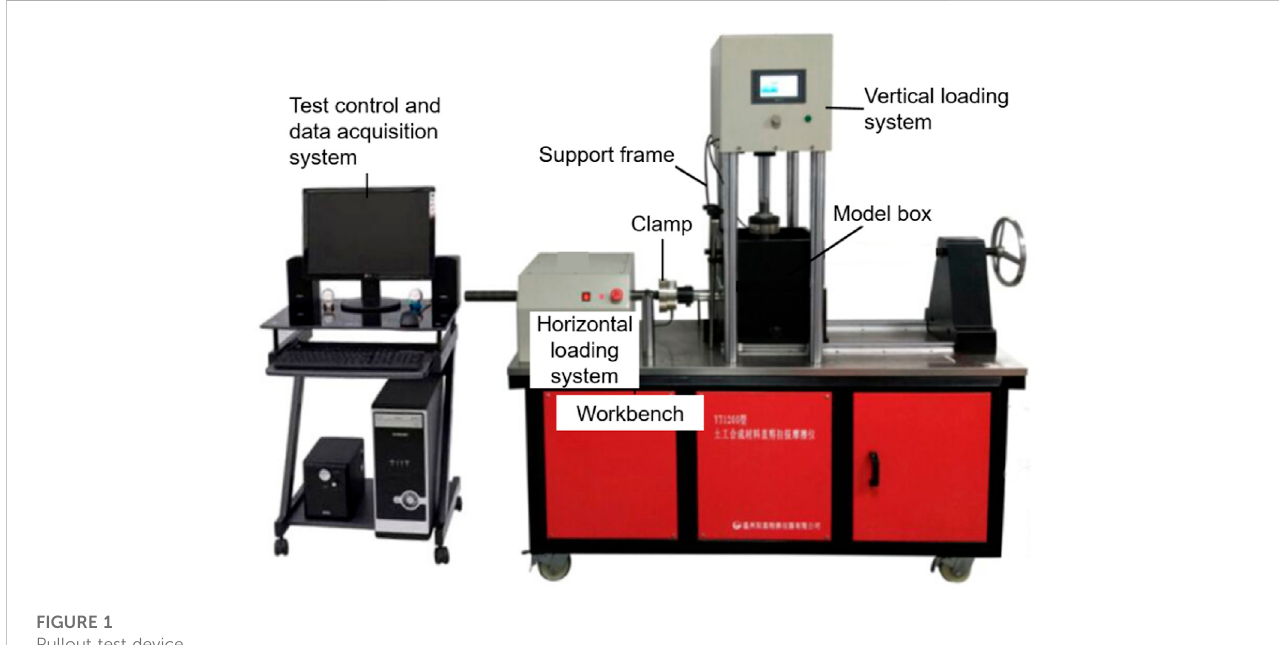
FIGURE 1 Pullout test device.